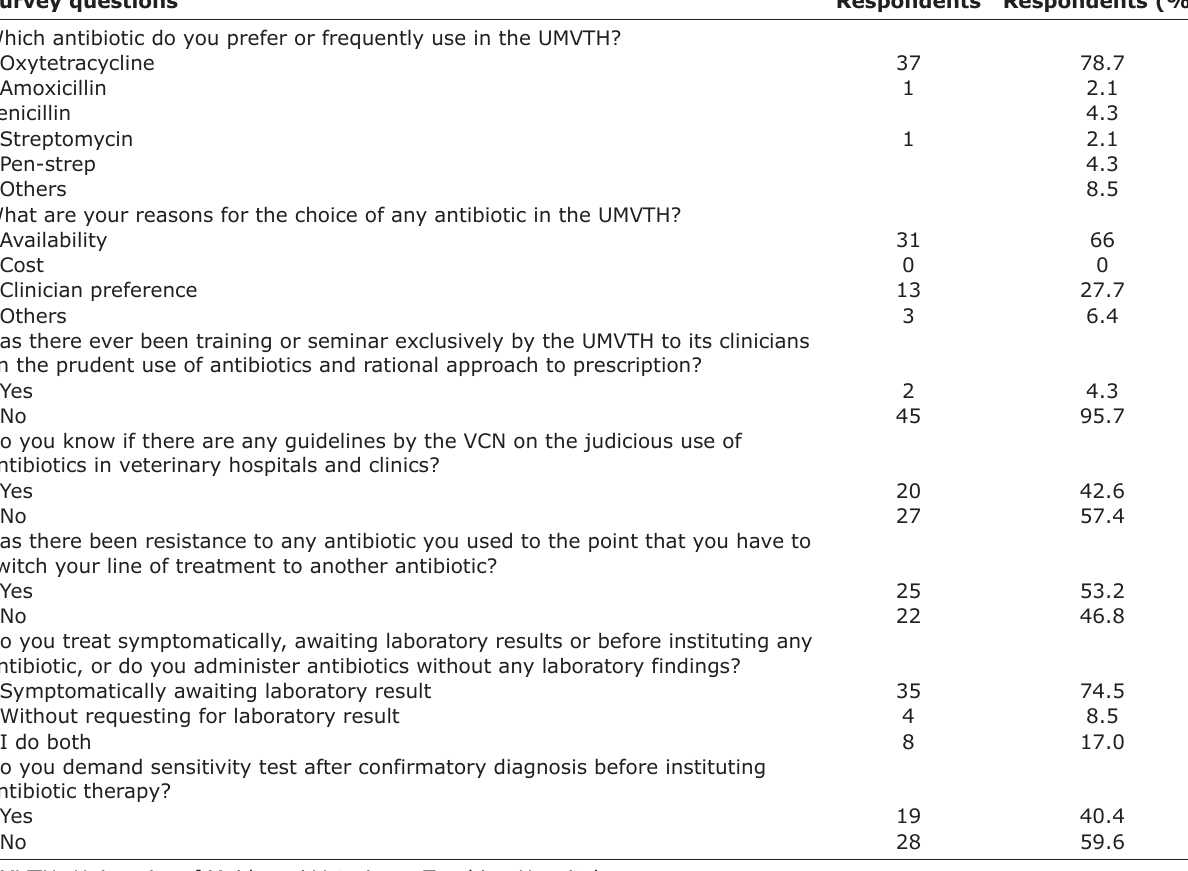
Table-3: Response to a questionnaire survey on the use of antibiotics by clinicians at the UMVTH Survey